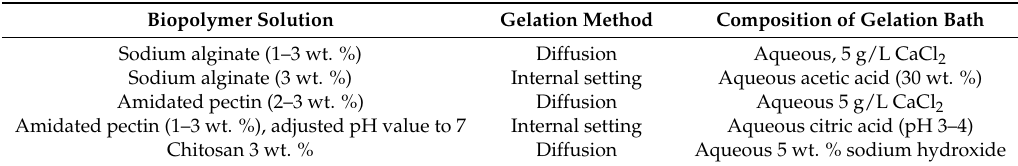
Table 2. Processed jet cutting